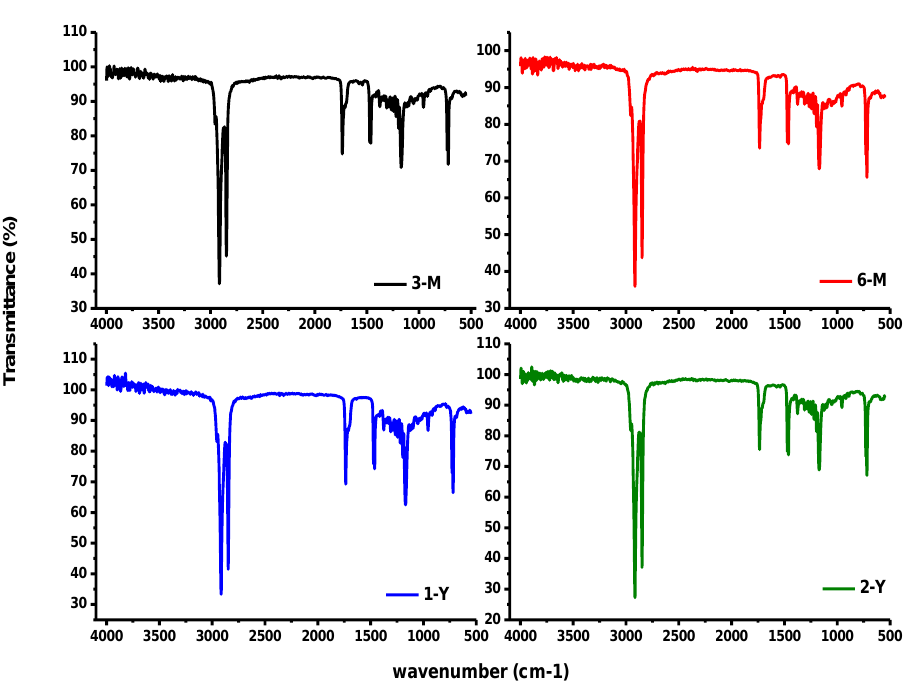
Figure 4. Fourier Transform Infrared Spectra (FTIR) of four BW samples with different storage times.